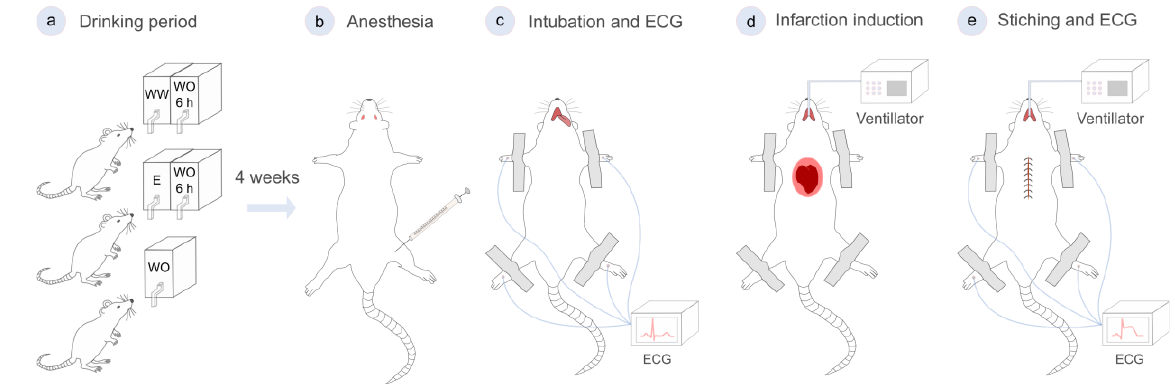
Figure 2. Workflow of the study. ( a ) Rats were divided into three treatment groups—a group drinking white wine (WW), a group drinking 13% ethanol (E) and a group drinking water only (WO). Aside from ad libitum access to alcoholic beverages, the wine and ethanol drinking groups had access to water for 6 h per day (WO 6 h). ( b ) Anesthetic was administered in the right hamstring muscle. ( c ) First ECG recording prior to surgery. ( d ) Surgically induced MI. ( e ) Second ECG recording in order to confirm the